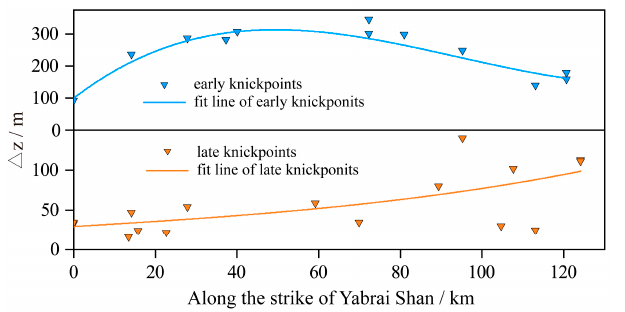
Figure 12. Scatter point distribution map of knickpoints in Yabrai Shan. ∆𝑧 indicates the elevation difference between knickpoints and the watershed outlet. The blue points represent the early knickpoints and the orange points represent the late knickpoints. The line represents the fitting of the elevation difference between the knickpoints and the outlet.